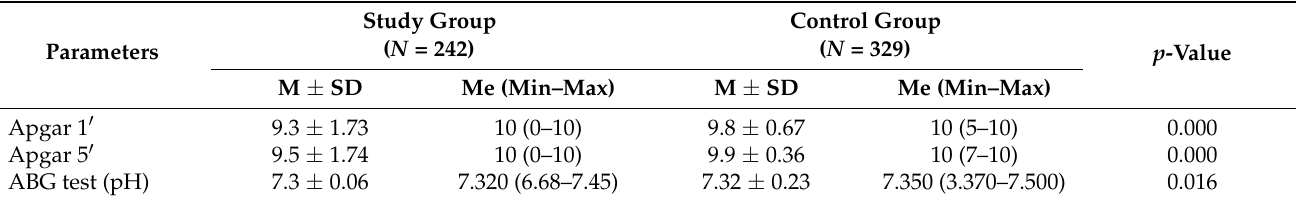
Table 4. Selected neonatal parameters in the study population.